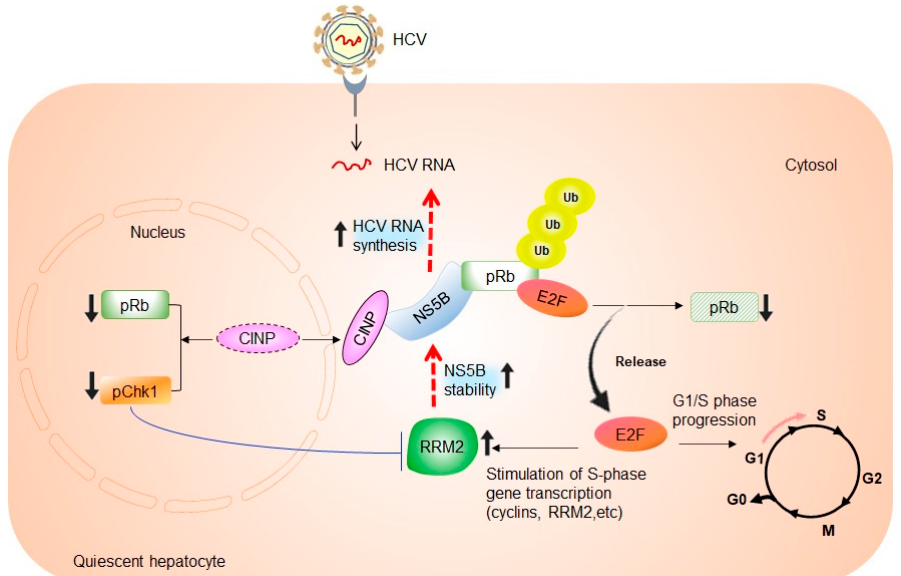
Figure 1. Role of the RRM2-NS5B interaction in regulating hepatocyte cell cycle regulation and proliferation. NS5B protein forms a complex with the retinoblastoma tumor suppressor protein (pRb), thereby targeting it for ubiquitination and proteasome-mediated degradation. This results in the release of the E2F transcription factor and activation of E2F-responsive promoters. Likewise, there is a stimulation of transcription of S-phase genes, including RRM2, G1- to S-phase progression, and therefore, cell proliferation [46]. Increased RRM2 expression enhances the stability of the NS5B protein, and in turn, HCV RNA replication [15]. On the other hand, NS5B interacts with the cyclin- dependent kinase 2-interacting protein (CINP), resulting in its relocalization from the nucleus to the cytoplasm. CINP relocalization results in the reduction of phosphorylated pRb and checkpoint kinase 1 (pChk1) abundance levels [50]. Chk1 depletion induces transcriptional suppression of RRM2 . This may result in S-phase delay and suppression of cell proliferation [56].